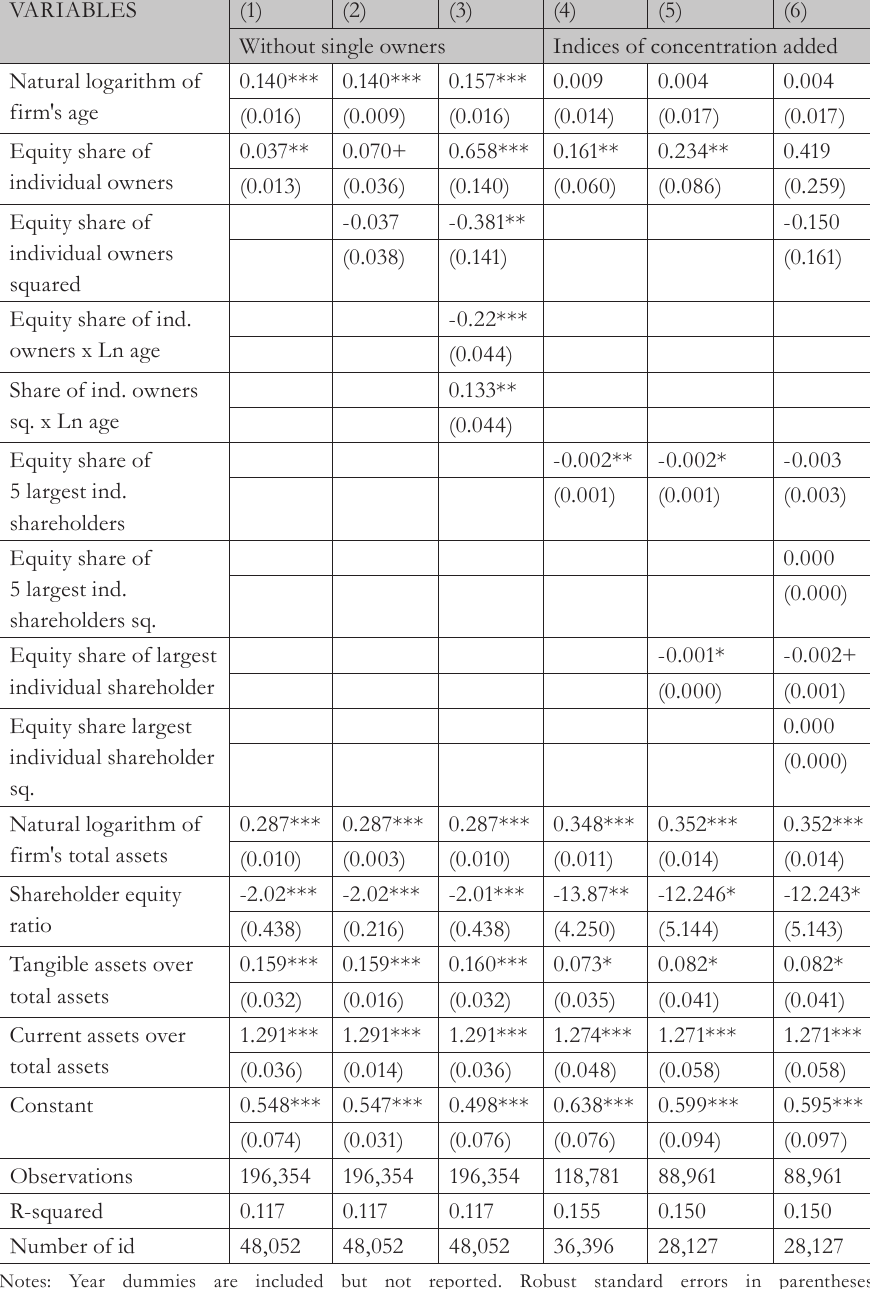
Tab. 3 – Fixed effects models. Dependent variable: TPF. Robustness checks. Source: own